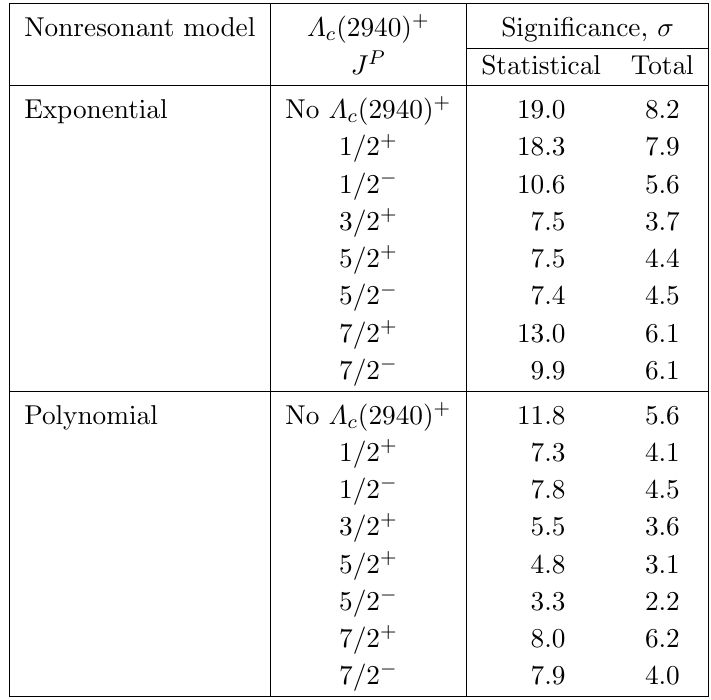
Table 12 . Signi(cid:12)cances of the J P = 3 = 2 (cid:0) spin-parity assignment for (cid:3) c (2940) + state with respect to the alternative models without a (cid:3) c (2940) + contribution or with other spin-parity assignments.